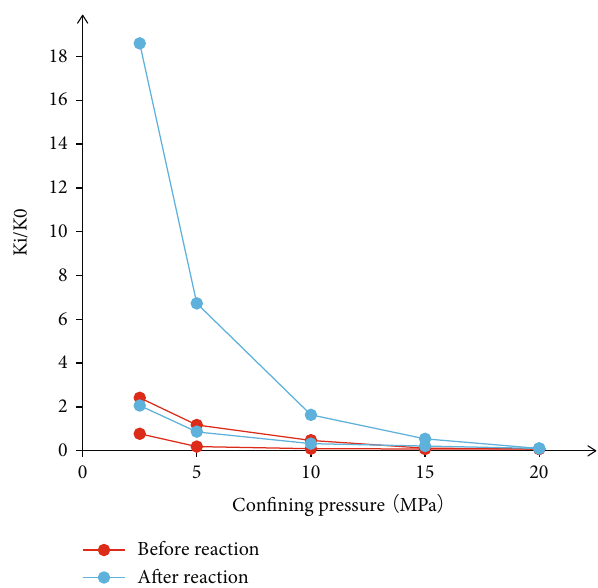
Figure 6: Stress sensitivity of shale before and after interaction with 5000 mg/L NaCl solution for 48